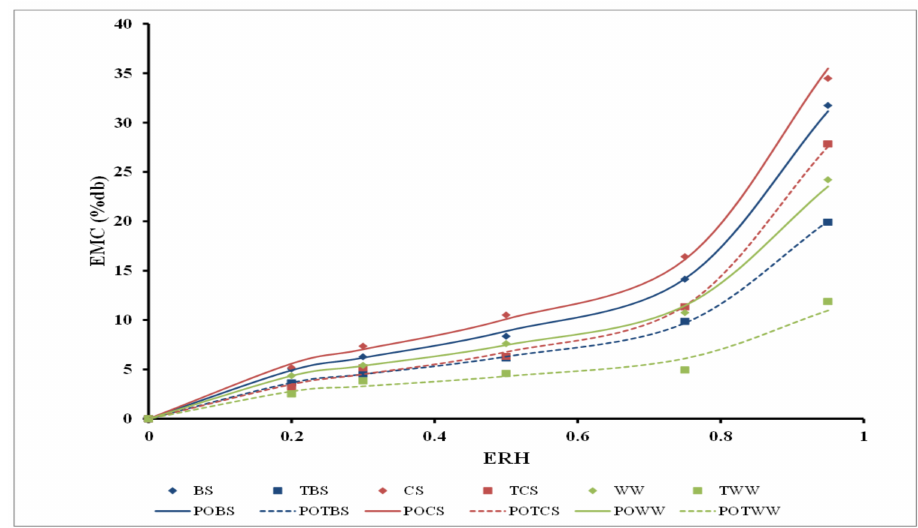
Figure 4. Experimental result and isotherms predicted by Oswin (PO) model for raw and tor- refied biomass.